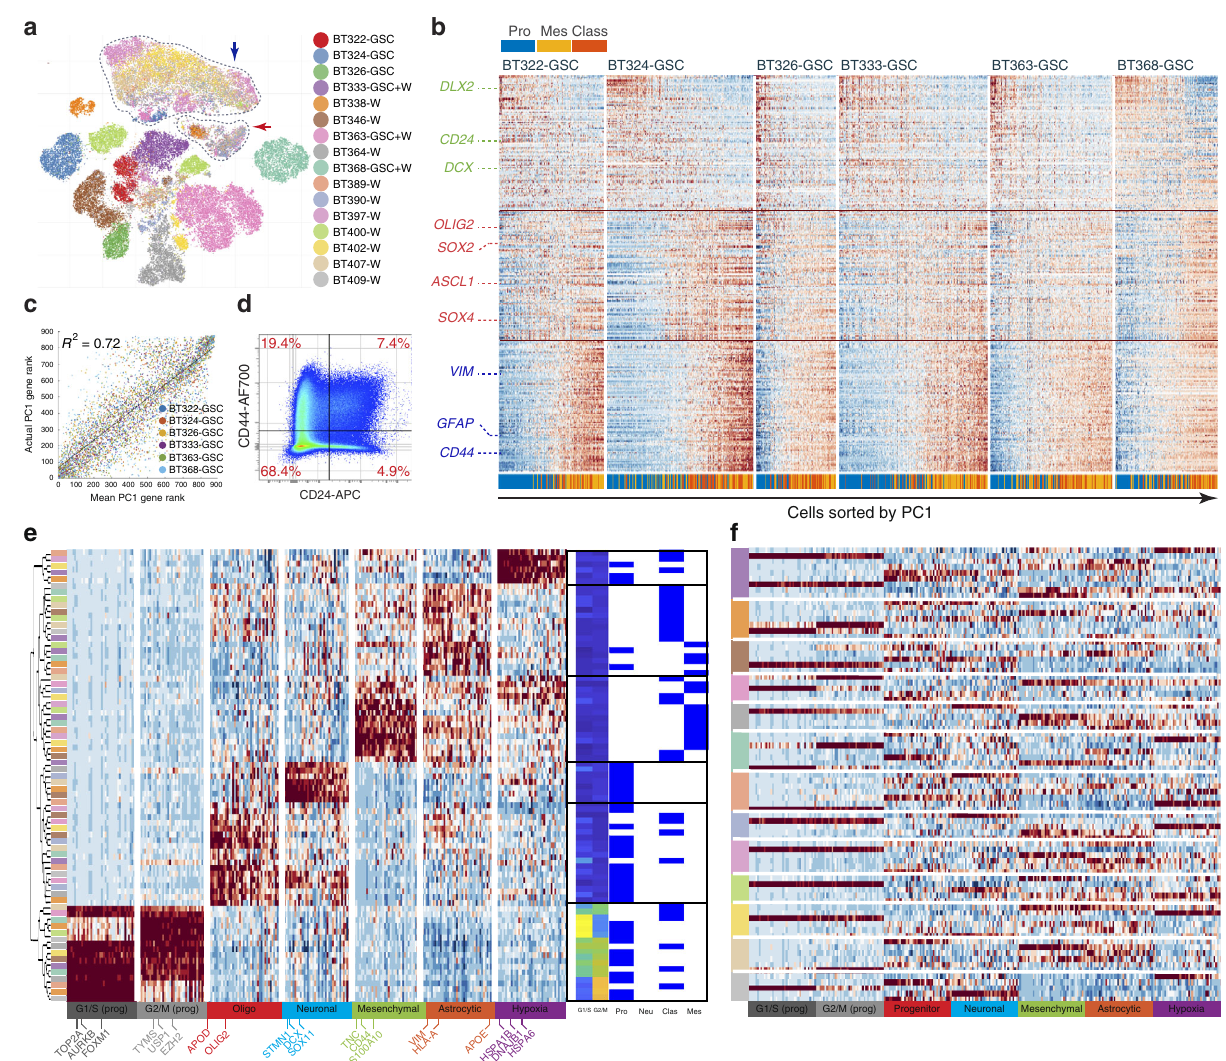
Fig. 1 Single-cell RNA sequencing highlights transcriptomic heterogeneity in glioblastoma and glioblastoma stem cells. a tSNE of location-averaged transcriptome for all tumor cells colored by patient. Cancer cells cluster by patient, whereas normal cells from all patients cluster together (encircled clusters indicated by arrows). GSC corresponds to glioma stem cell samples, W corresponds to whole samples. b Enriched glioblastoma stem cell (GSC) gene expression heatmaps showing relative gene expression (raw data) sorted by PC1 per patient. These maps are separated into three rows: top row — 100 genes with the lowest value for PC1 loading; bottom row — 100 genes with the highest value for PC1 loading; middle row — 100 genes with the highest value for PC2 loading. These gene signatures correspond to neuronal, astrocytic, and progenitor signatures, respectively. The TCGA subtype is also shown for each GSC. c Mean and actual rank of genes by PC1 correlation. The actual gene rank ( y axis, one point per sample) correlates strongly with the mean gene rank ( x axis) in all patients. d Flow cytometry analysis of GSCs and whole-tumor, demonstrating mutually exclusive expression of CD24 and CD44. e Heatmap of gene expression by cNMF signature with associated cell cycle scores and TCGA subtype (right). The most characteristic genes for each signature group are depicted on the x axis. Signatures ( y axis) are ordered according to hierarchical clustering (left tree). Left color bar represents the patient sample that generated each signature — patient colors match those in Fig. 1a. Red represents high expression; blue represents low expression. Gene signatures groupings correspond to progenitors, astro-glia (mesenchymal and classical), and neurons, with the addition of cell cycle and hypoxia signatures. cNMF — clustered non-negative matrix factorization. f Heatmap of gene expression by signature ordered by patient as shown by the left color bar. Genes ( x axis) are in the same order as Fig. 1e. Patient colors in the color bar match those in Fig. 1a, e. Each patient contains signatures from multiple